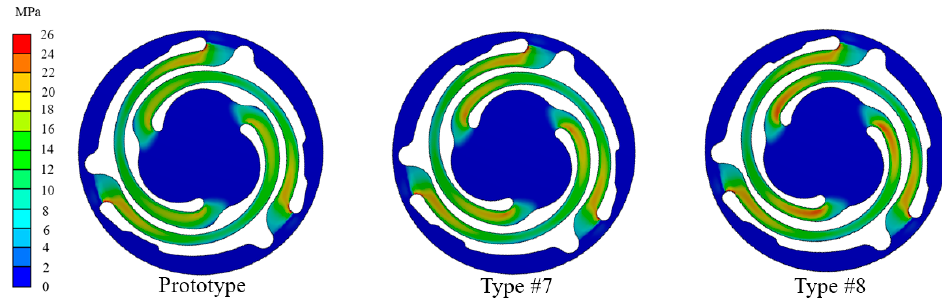
Figure 21. von Mises stress distribution on spring with different width #2 parameters. Table 6. Analysis result comparison between different width #2 parameters.